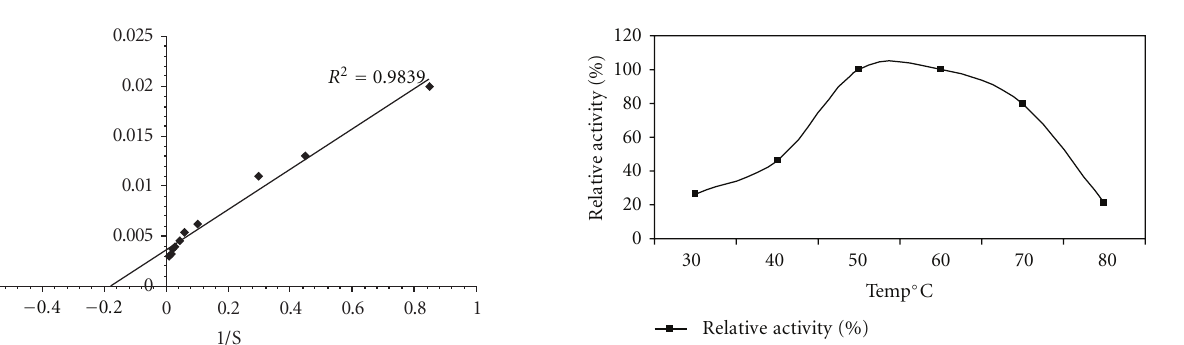
Figure 7: E ff ect of temperature on activity of xylanase from Bacillus arseniciselenatis DSM 15340.